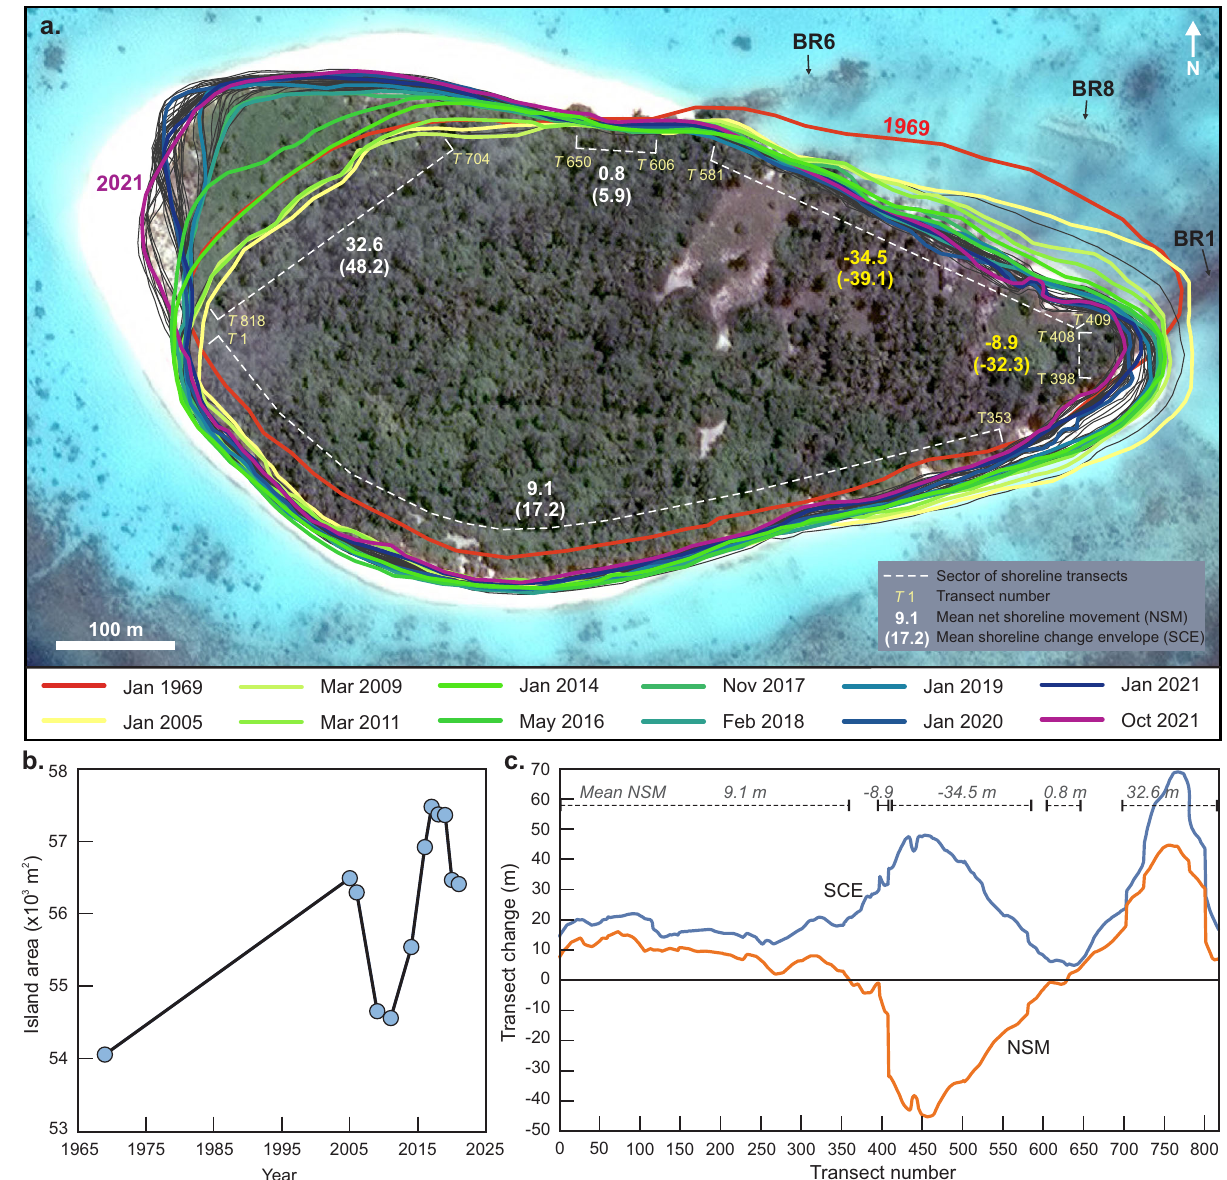
Fig. 4 | Summary changes in the Kandahalagalaa shoreline 1969 – 2021. a Planform changes in the vegetated shoreline. Note summary values of net shoreline movement (NSM) and shoreline change envelope (SCE), in brackets, for speci fi c sectors of the island (dashed white lines). Imagery © 2019 Maxar